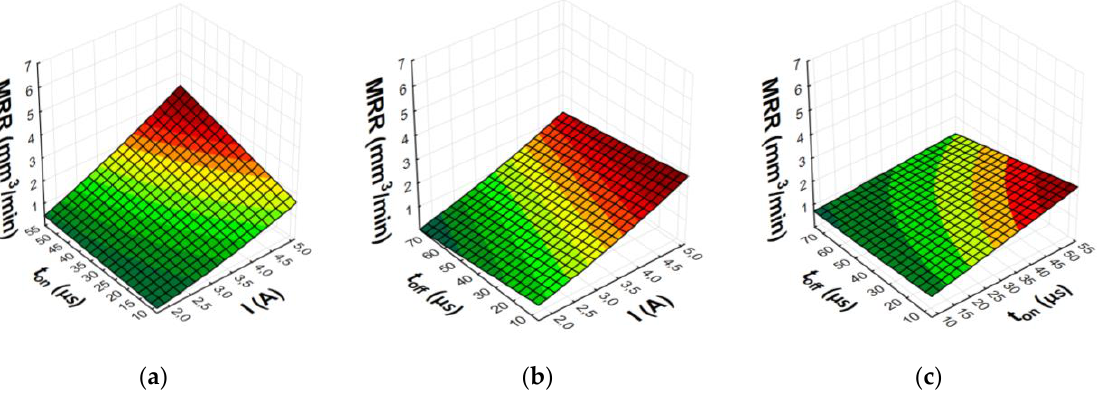
Figure 7. Graphical representation of regression equation for MRR of AF-5 graphite electrode: ( a ) t off = 40.5 µ s; ( b ) t on = 31.5 µ s; ( c ) I = 3.4 A.